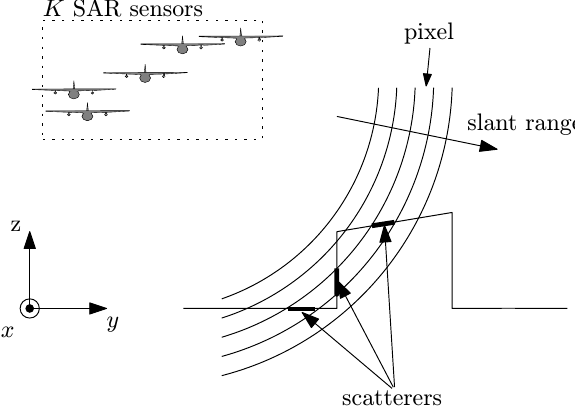
Figure 4: Illustration of tomographic SAR principle: due to the acquisition geometry of a SAR sensor, the backscattering of sev- eral targets may be superposed in the same pixel. This effect is called layover. Moreover, the altitudes are lost. To separate and localize these scatterers in the 3D space, SAR tomography com- bines several images acquired with slightly different incidence angles.